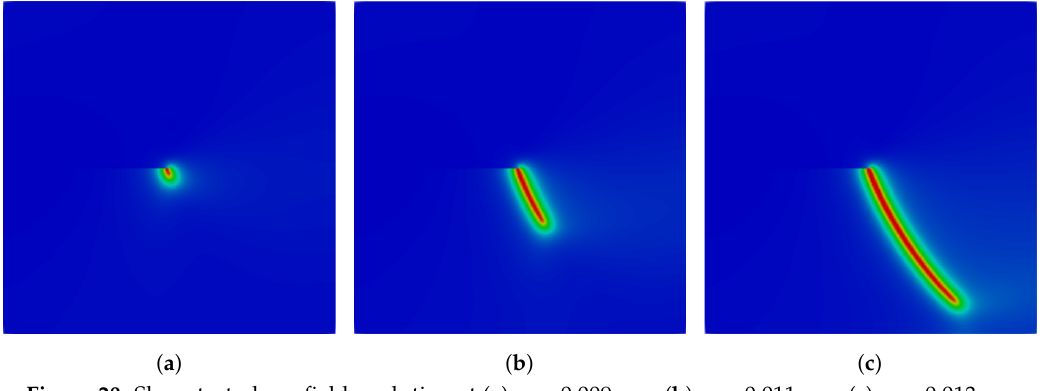
Figure 20. Shear test phase field evolution at ( a ) u = 0.009 mm ( b ) u = 0.011 mm ( c ) u = 0.013 mm, with displacement increment ∆ u = 1 e − 6